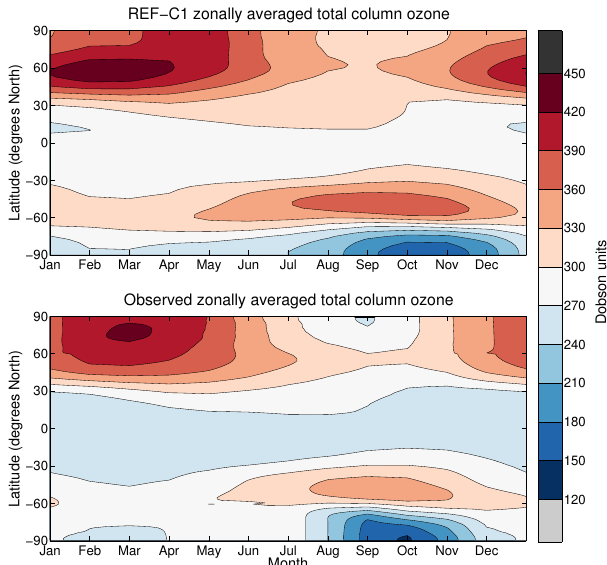
Figure 1. Zonally averaged (2005–2010) TCO for the REF-C1 hindcast simulation compared to observations from the Bodeker Scientific total column ozone database.